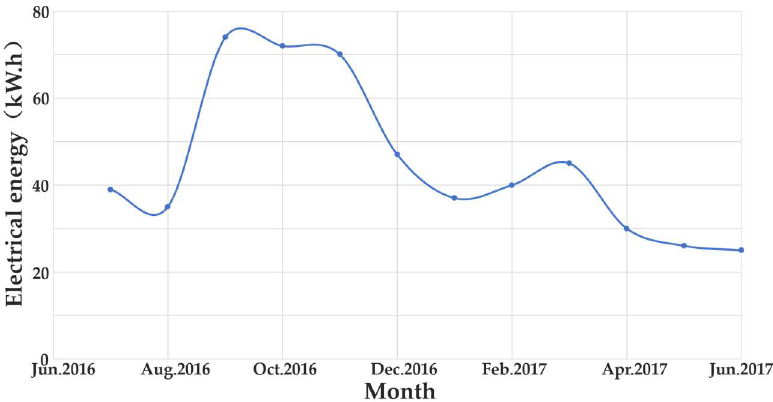
Figure 10. Monthly distribution of tidal power generation